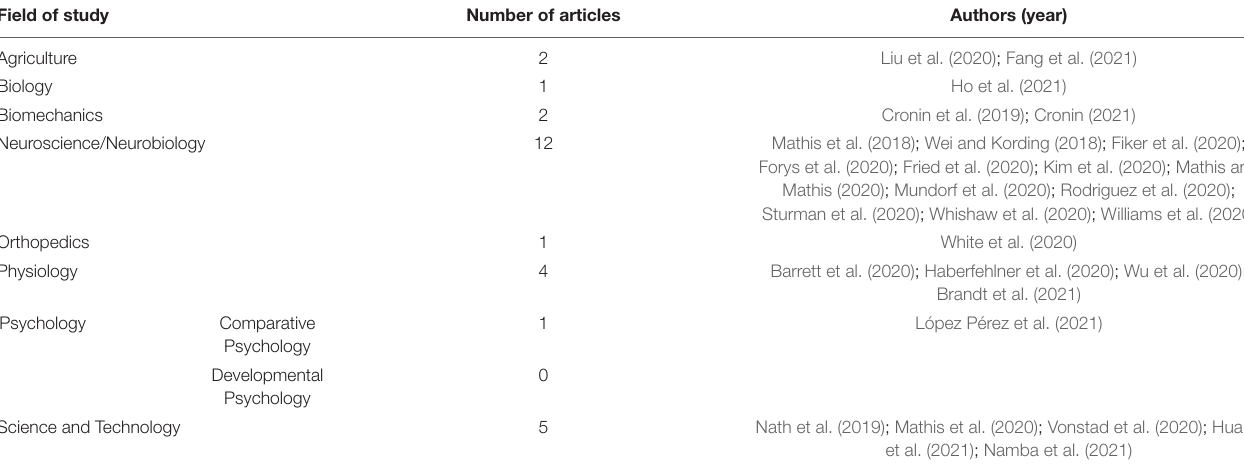
TABLE 1 | A breakdown of peer-reviewed studies that have used DeepLabCut, organized by field of study, between 2018 and